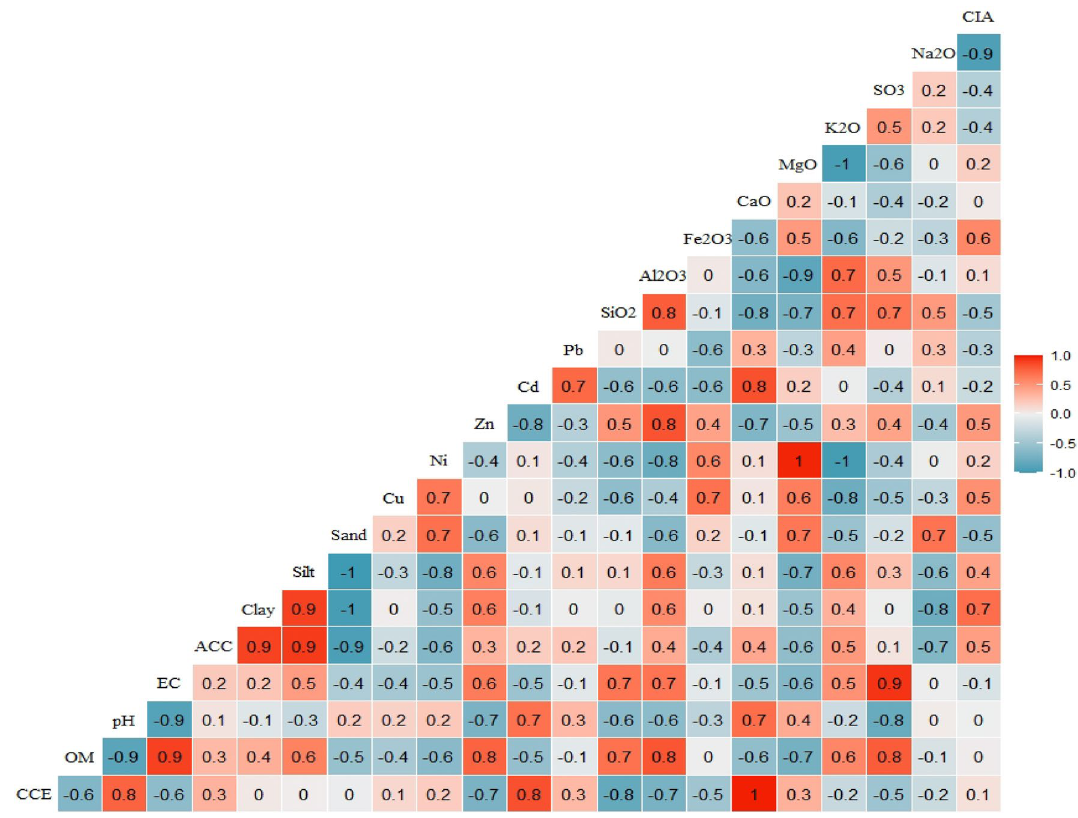
Figure 3. Pearson correlation coefficients among selected sediment